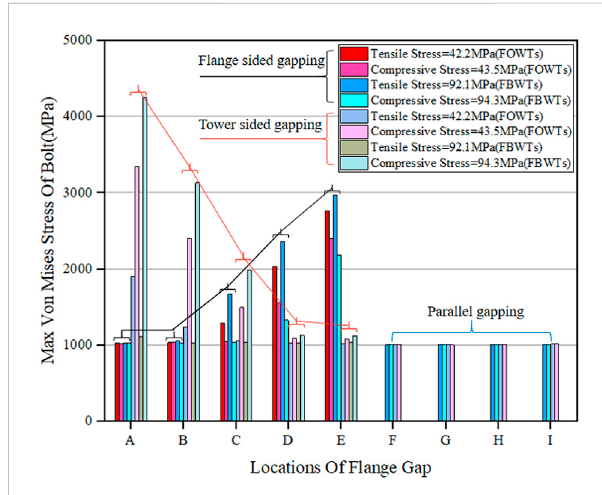
FIGURE 13 MaximumvonMisesstressoftheFOWTs ’ andFBWTs ’ towerbolts under fl atnessdivergence(detailsofthelocationofopeningsaregiven in Figure